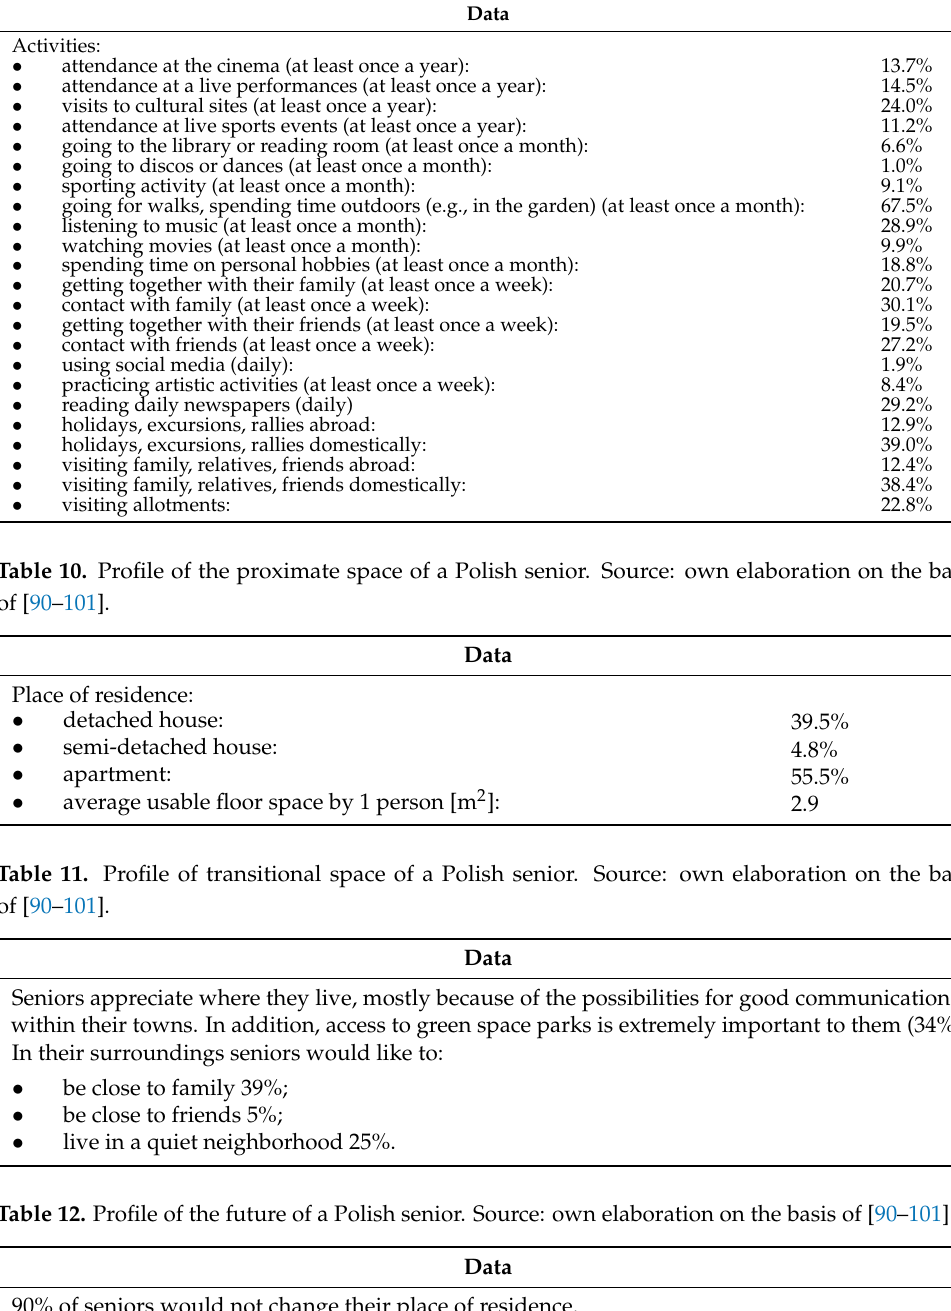
Table 9. Profile of activity needs of a Polish senior. Source: own elaboration on the basis of [90–101].